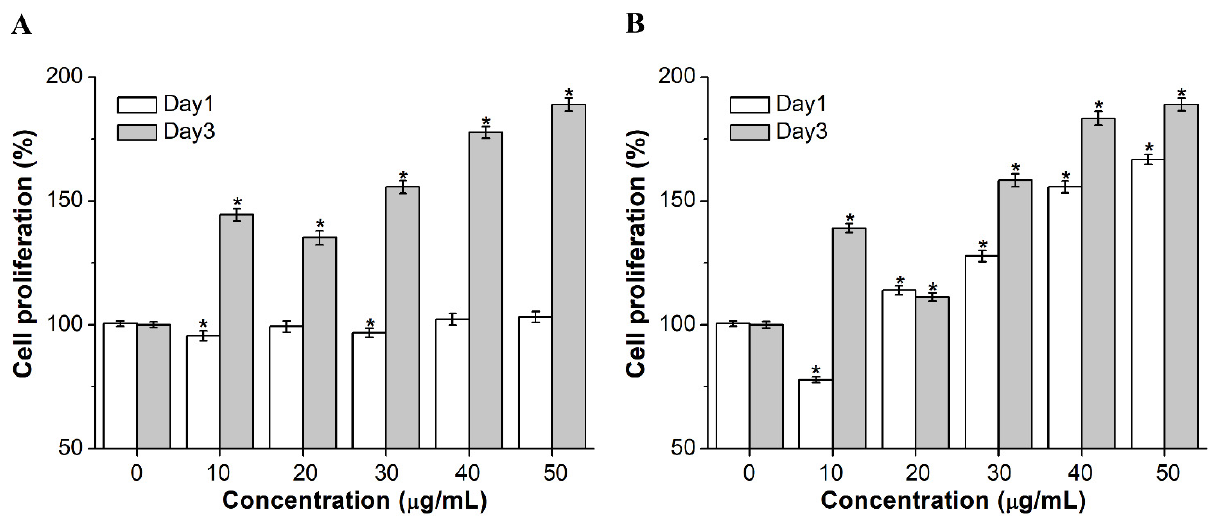
Figure 2. Proliferative effects of hucMSCs-exo on HUVECs and NIH-3T3 cells. ( A ) HUVECs and ( B ) NIH-3T3 cells were treated with hucMSCs-exo at different concentrations. Untreated hucMSCs- exo was used as the control group. Data represent the mean ± SD (n = 3), * p <